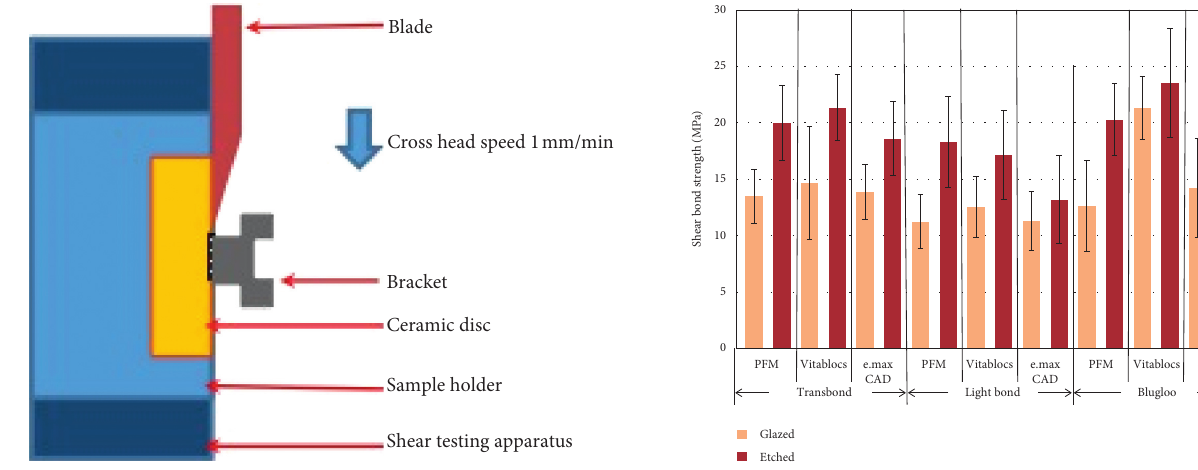
Figure 3: Histogram presenting shear bond strength of metal brackets to the ceramic materials tested with three cements and etching effects.